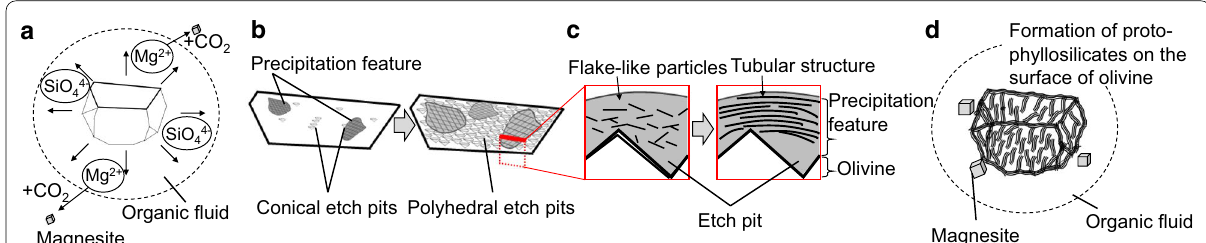
Figure 5 Schematic image of proto-phyllosilicate formation on the olivine surface. a Dissolution of olivine into the organic fluid. Magnesite formation also proceeded. b Precipitation features cover the olivine surface. Etch pits evolved with the dissolution progress. These features were confirmed using SEM. c Flake-like particles evolved to a tubular structure, from amorphous to crystalline, in the precipitation features. These features were confirmed using TEM. d Formation of crystalline proto-phyllosilicates on the olivine